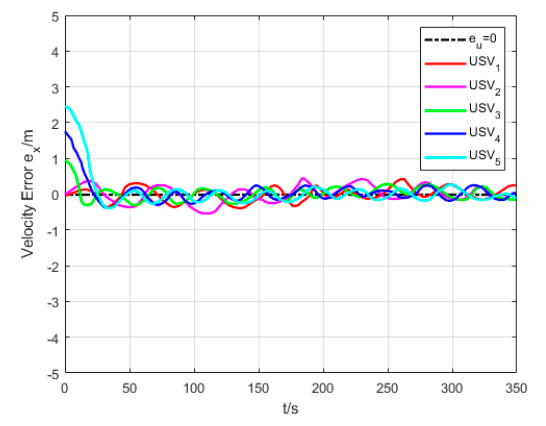
Figure 26. Velocity error (Algorithm 4).